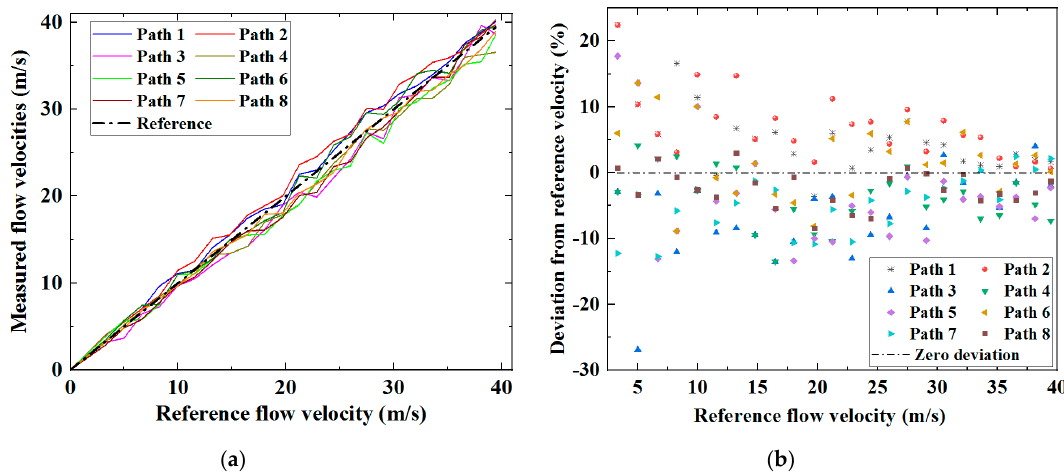
Figure 9. ( a ) Average flow velocity measured by the ultrasonic flow meter and ( b ) the deviation of this measurement from the reference.